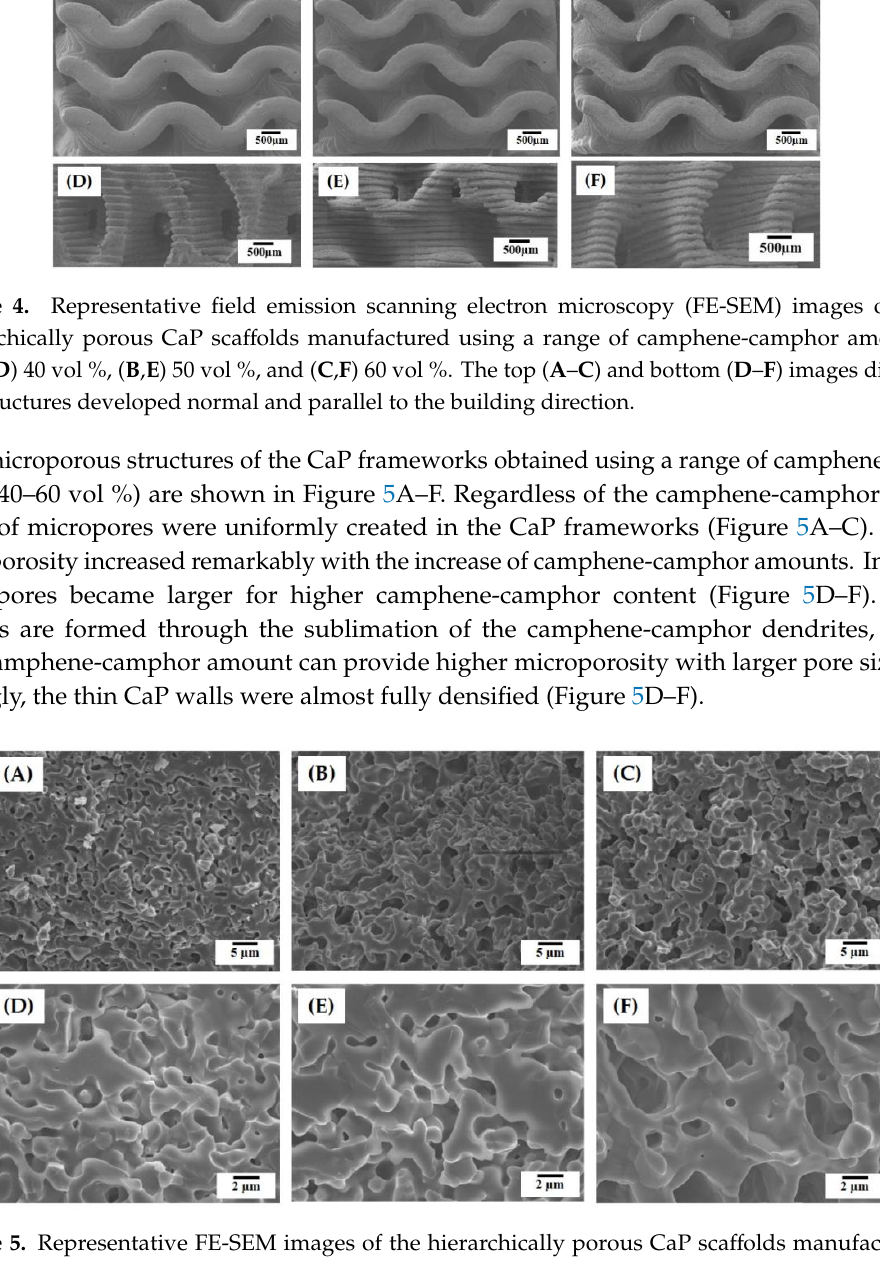
Figure 5. Representative FE-SEM images of the hierarchically porous CaP scaffolds manufactured using a range of camphene-camphor amounts showing their microporous structures: ( A , D ) 40 vol %, ( B , E ) 50 vol %, and ( C , F ) 60 vol %.